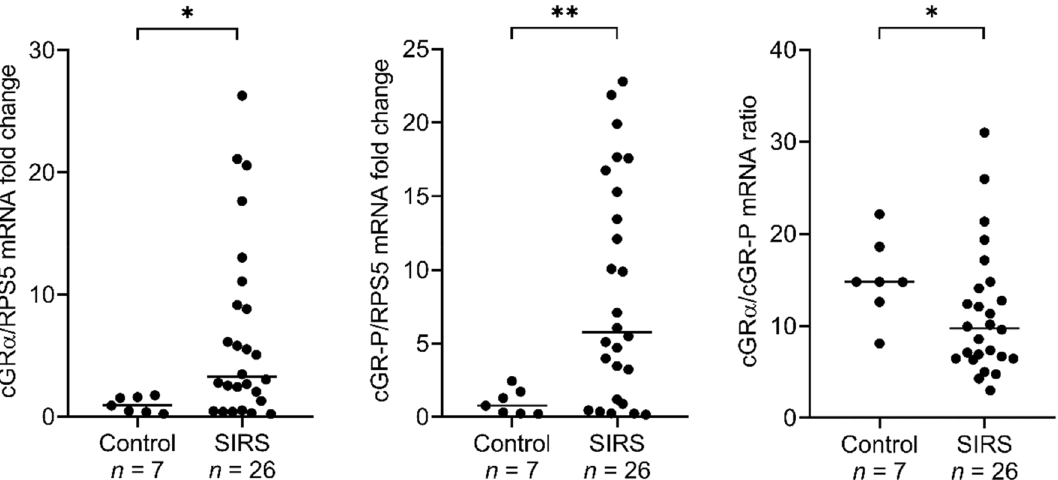
Figure 2. Real-time PCR analysis of cGRα and cGR-P mRNA expression and cGRα/cGR-P mRNA ratios in the control group and dogs suffering from SIRS. The number of dogs studied in each group is indicated under the graphs. cGRα and cGR-P mRNA expressions are normalized to reference gene RPS5 expression and presented as fold changes compared to the mean of the control group. The lines represent the median values. Comparisons between two groups were performed by nonparametric Mann–Whitney U test. Statistically significant differences are depicted by * p < 0.05 and ** p < 0.01.